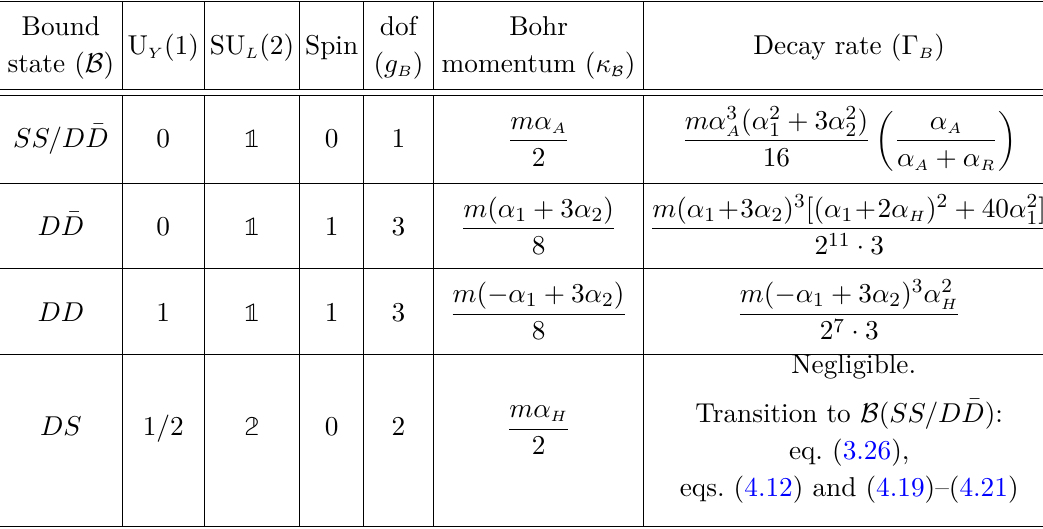
and α are A R | = κ 2 /m B B